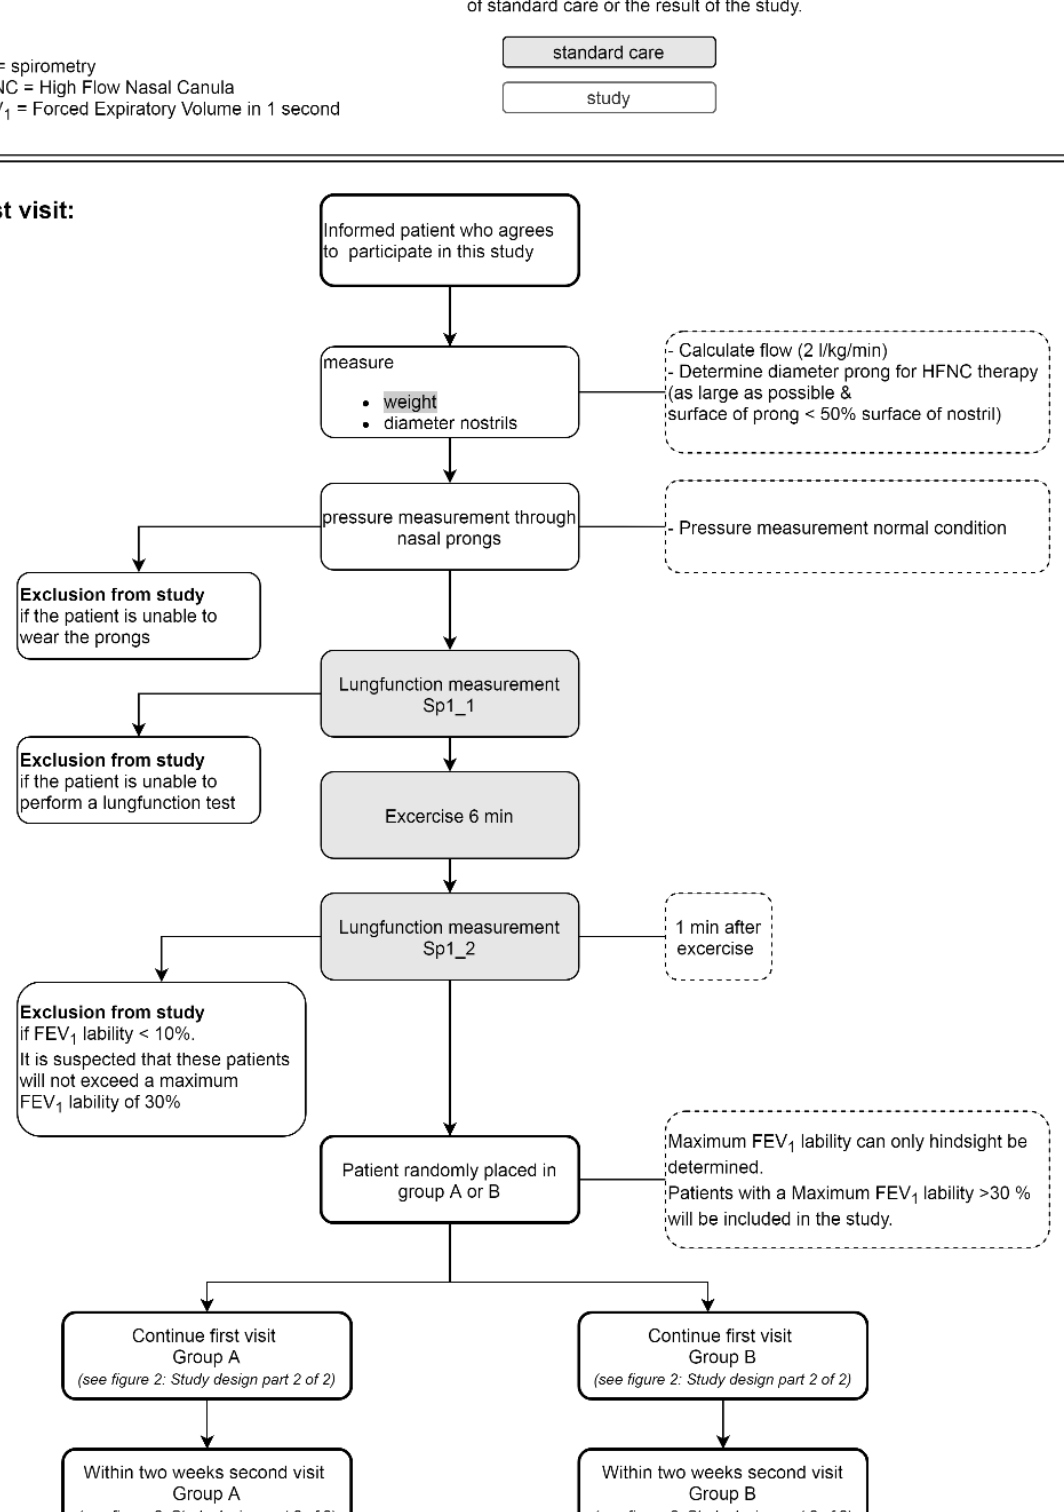
Study design (part 1 of